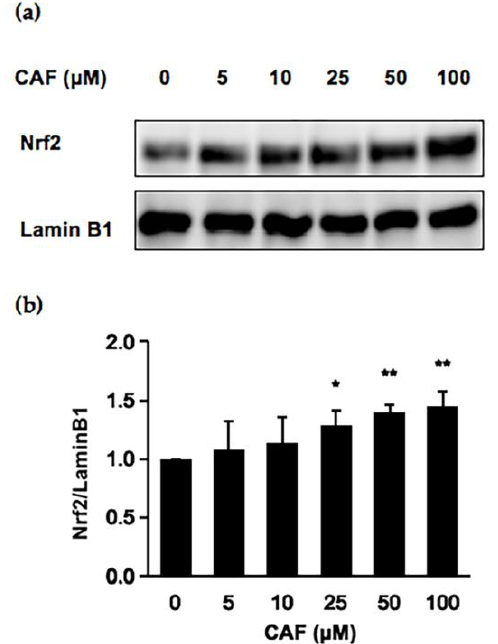
Figure 3. Modulating effects of CAF on the nuclear factor erythroid 2-related factor 2 (Nrf2) level ( a , b ). The nuclear fraction was separated from Hepa1c1c7 cells treated with CAF for 6 h, then a Western blot analysis for each protein was carried out. All values were expressed as means ± SD and analyzed by Student’s t-test (* p < 0.05, ** p < 0.01 compared to control).